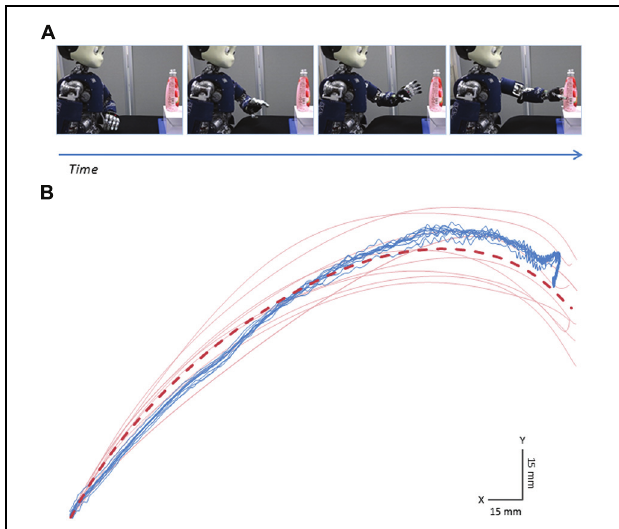
FIGURE 2 | It is possible to replicate simple movements with a humanoid robot that are sufficiently similar to those of a human actor. Here we show an example where the robot approximates a previously recorded human reaching. (A) Snapshots of the humanoid robot iCub reaching for a bottle with the aim to pour its content (i.e., pouring intention). (B) Sample trajectories of the palm of the hand on the horizontal (X) and vertical (Y) planes of the motion. Blue lines represent robot actions while red lines indicate human motions. Each line refers to a single movement. Data from ten trials are reported. It can be noticed that robot motion is highly repeatable and reflects quite accurately the average trajectory of the human action to be reproduced (dashed red line). Image by Oskar